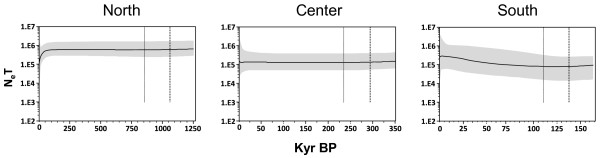
COI Bayesian skyline plots for each haplogroup of M. laminarioides . Effective population size fluctuations throughout time are represented for the Northern, Center and Southern haplogroups. The solid line represents the median estimate and the grey area the 95% highest probability density. Abbreviations used: Ne = effective population size, T = time, BP: before present.